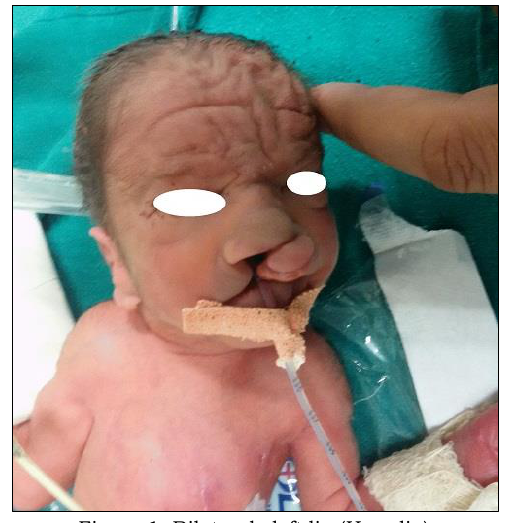
Figure 1: Bilateral cleft lip (Hare lip) The surgery was done on the baby on the next day. findings suggested an isolated 2cm x 3cm defect in the left diaphragm with herniating spleen, splenic flexure of colon and a part of left